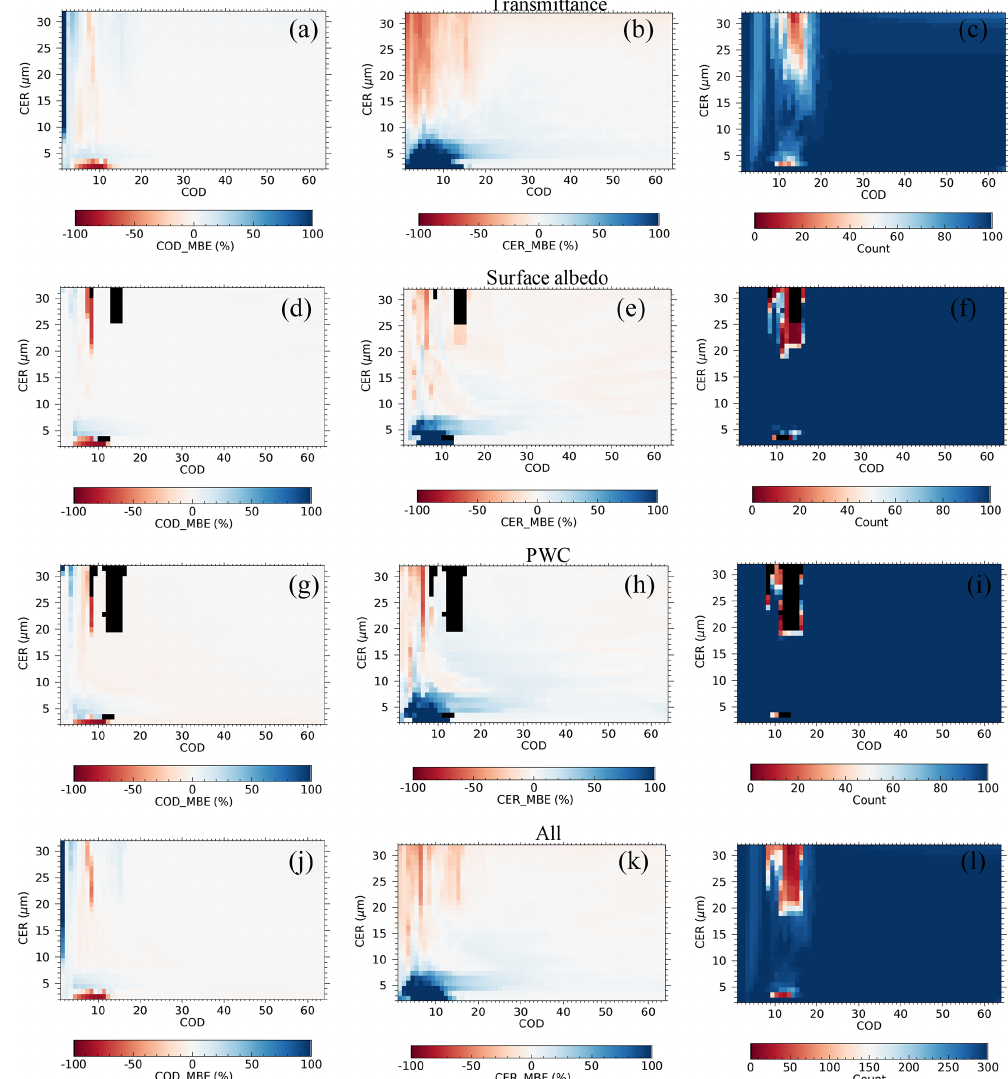
Figure 3. Mean bias error (MBE) values for the retrieved (a) cloud optical depth (COD) and (b) cloud particle effective radius (CER) and (c) the total number of successful retrievals for the assumed error in transmittance; (d) – (f) same as (a) – (c) but for the assumed error in surface albedo; (g) – (i) same as (a) – (c) but for the assumed error in precipitable water content; (j) – (l) same as (a) – (c) but for all error sources. The 100% unsuccessful retrieval is shown in